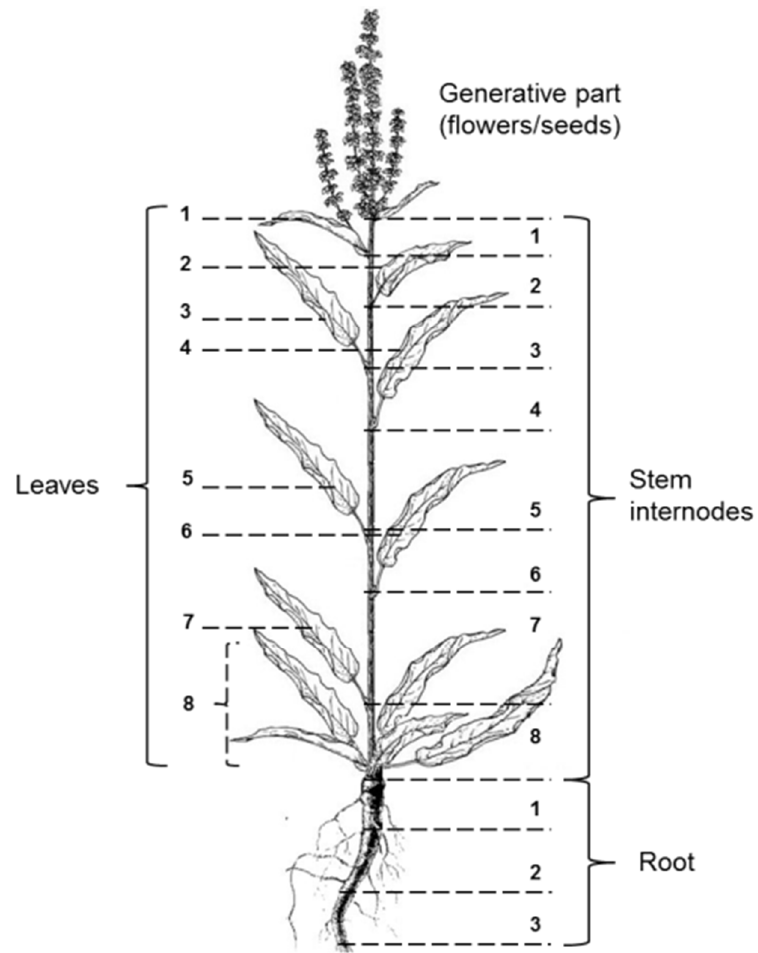
Figure 1. Scheme of the analysis of the vertical distribution of phytocomponents in sorrel plants.